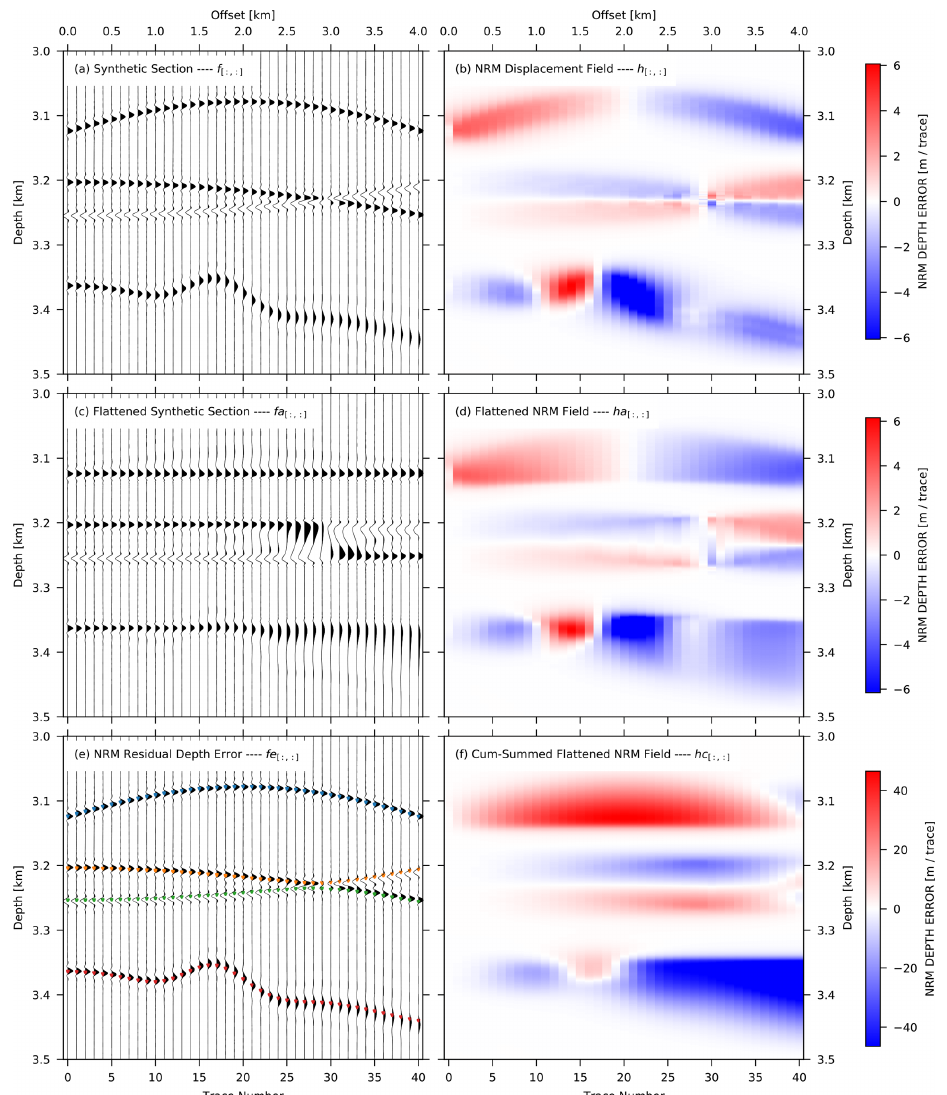
Figure 2. (a) Simulated complex geological situations that would be frequently seen in pre-stack depth-migrated (PSDM) common-image- point (CIP) domains. A symmetrical diffraction, two interfering parabolic events with opposite polarity, and parabolic event with a local curvature anomaly, including frequency versus offset signal variations. (b) The relative NRM displacement of gather (a) calculated from trace n to the previous trace ( n − 1) for n > 1. (c) Application of the displacement correction from (b) to the gather of (a) . (d) Application of the displacement self-correction of the gather of (b) . (e) Residual move-out picks calculated from the recursive cumulative sum of the relative depth errors (f) at predefined nearest-offset depths. (f) Cumulative sum calculated from (d)